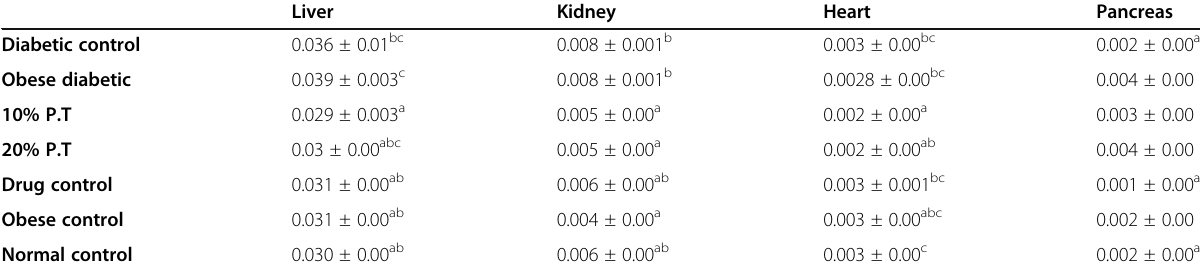
Table 6 Effect of Pleurotus tuber-regium on the organosomatic index of the diabetic rat Liver Kidney